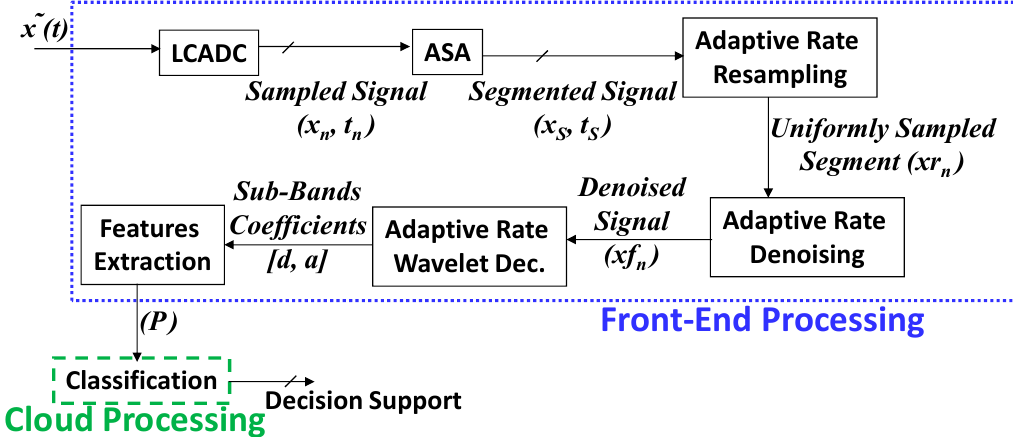
Figure 1. The proposed system block diagram. LCADC: level-crossing analog-to-digital converters; ASA: activity selection algorithm.